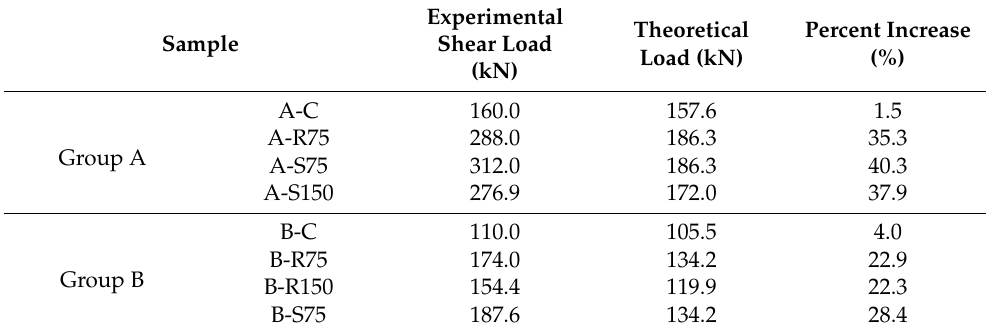
Table 5. Experimental and Theoretical Capacity